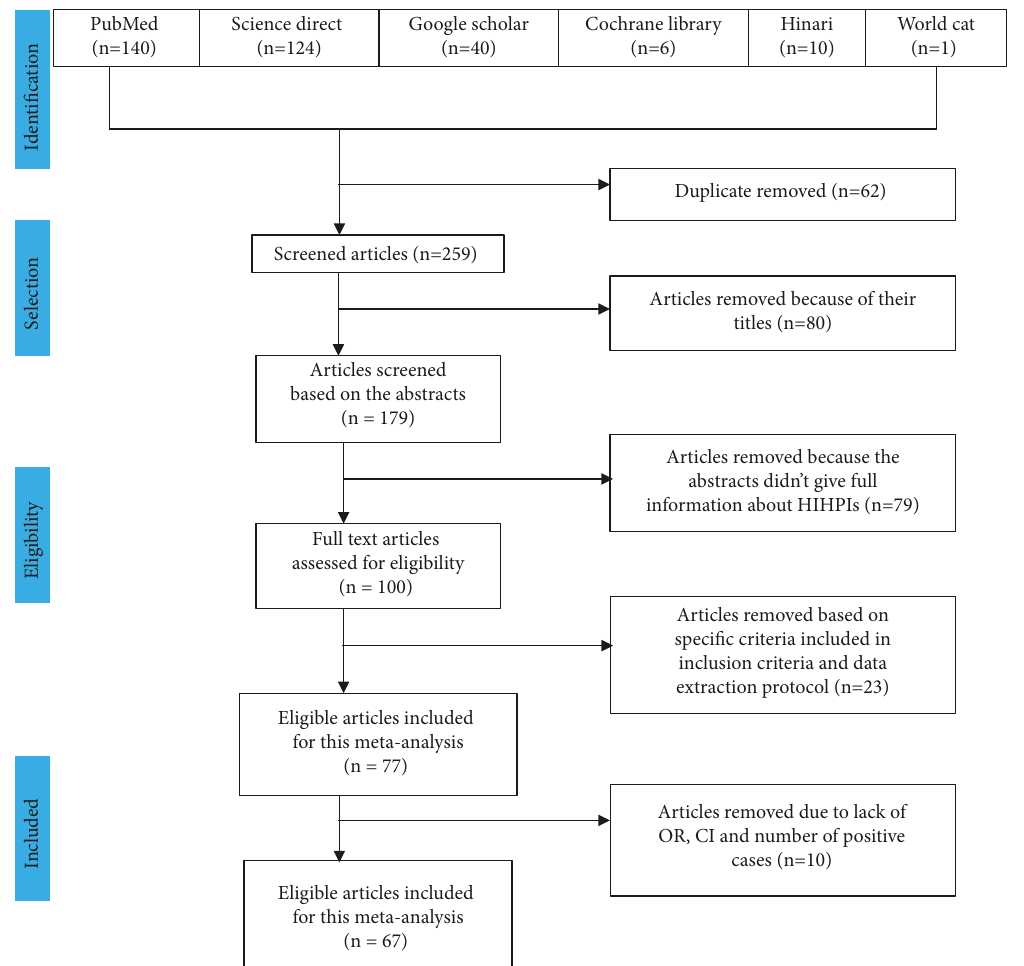
Figure 1: PRISMA flow diagram of articles considered for the review of HIHPIs among the Ethiopian